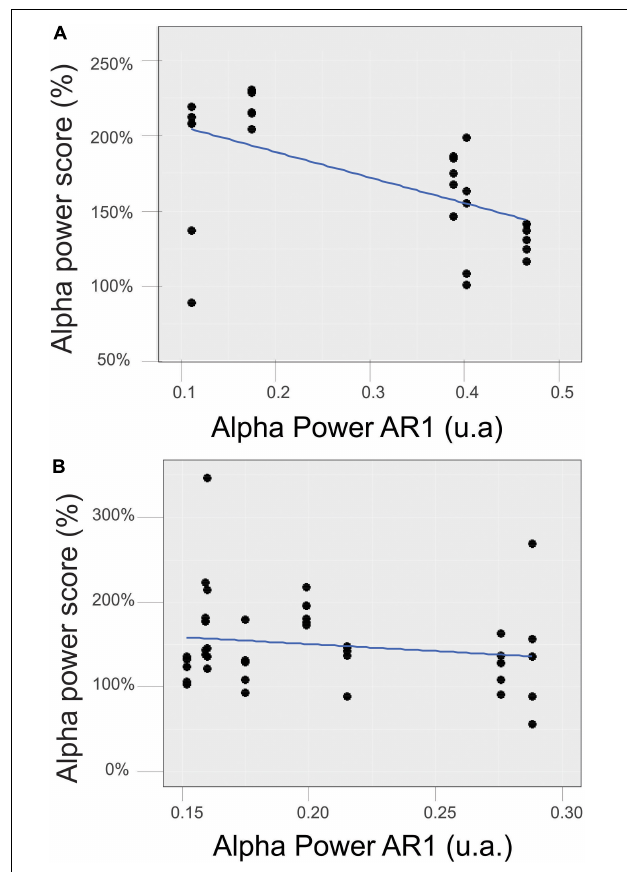
FIGURE 8 | Relationship between the mean initial control value of the alpha power in the EC (A) and EO (B) states measured during AR1 and the mean score reached during the RB session